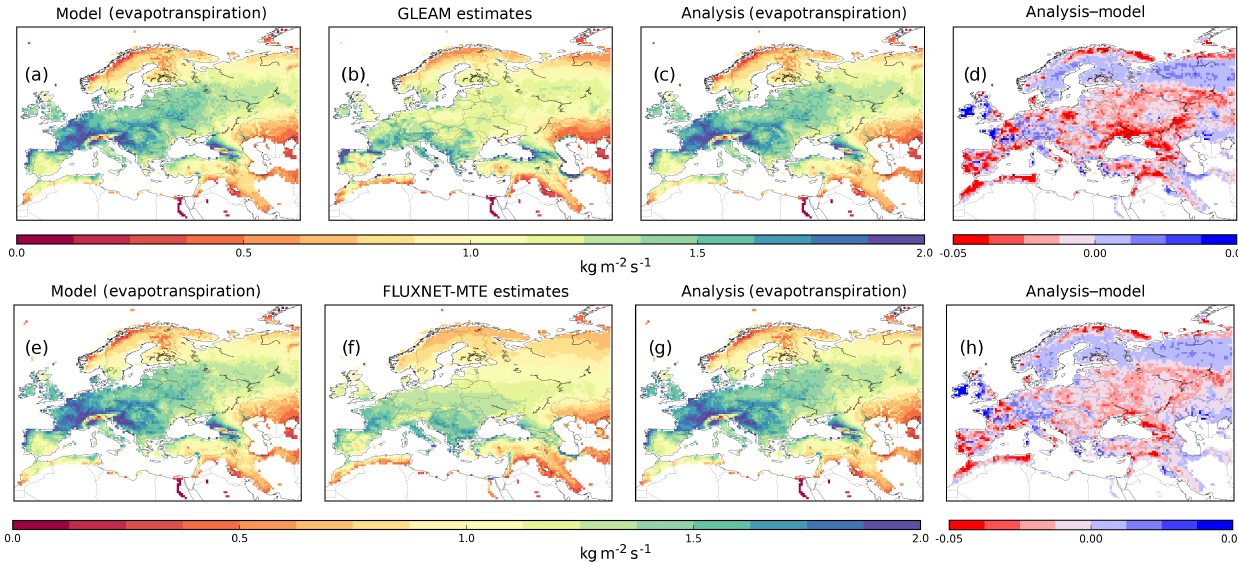
Figure 12. Top row: maps of averaged evapotranspiration taken over 2000–2012 from (a) the model (i.e open loop), (b) the GLEAM estimates, (c) the analysis and (d) differences between the analysis and model. Bottom row: maps of averaged evapotranspiration taken over 2000–2011 from (a) the model (i.e open loop), (b) FLUXNET-MTE estimates, (c) the analysis and (d) differences between the analysis and model.